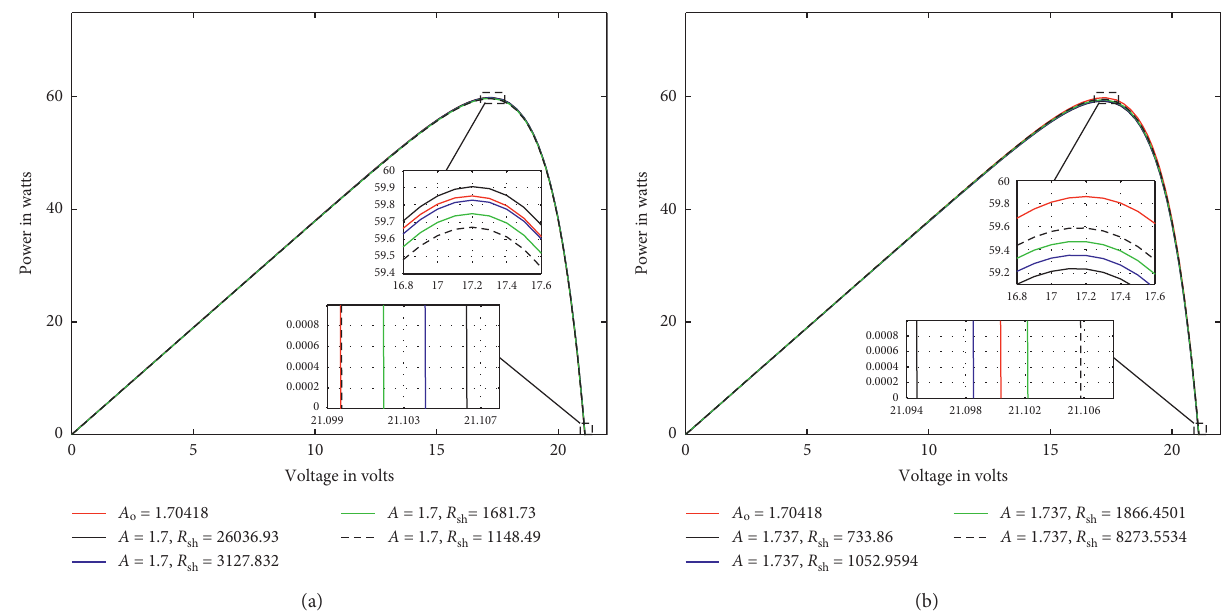
Figure 8: PV curves for MSX60 showing different ( R